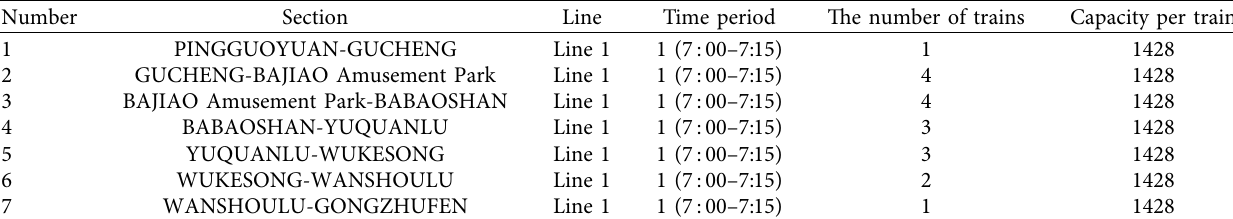
Table 3: Carrying capacities of sections during each time period